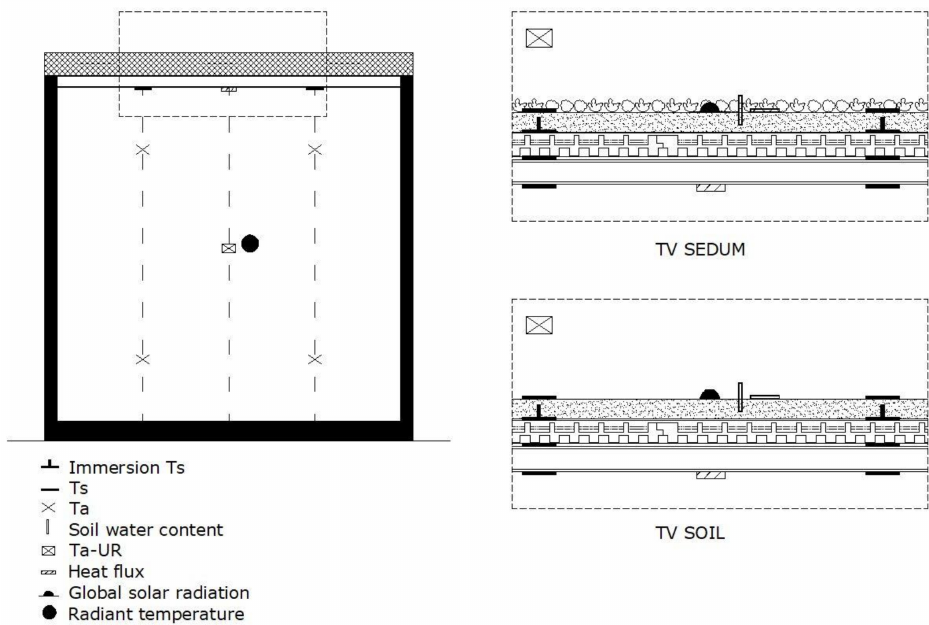
Figure 8. Stratigraphy distributions of the sensors for the two different roof solutions (TVSOIL and TVSEDUM) for the monitoring of surface and air temperatures, relative humidity and moisture